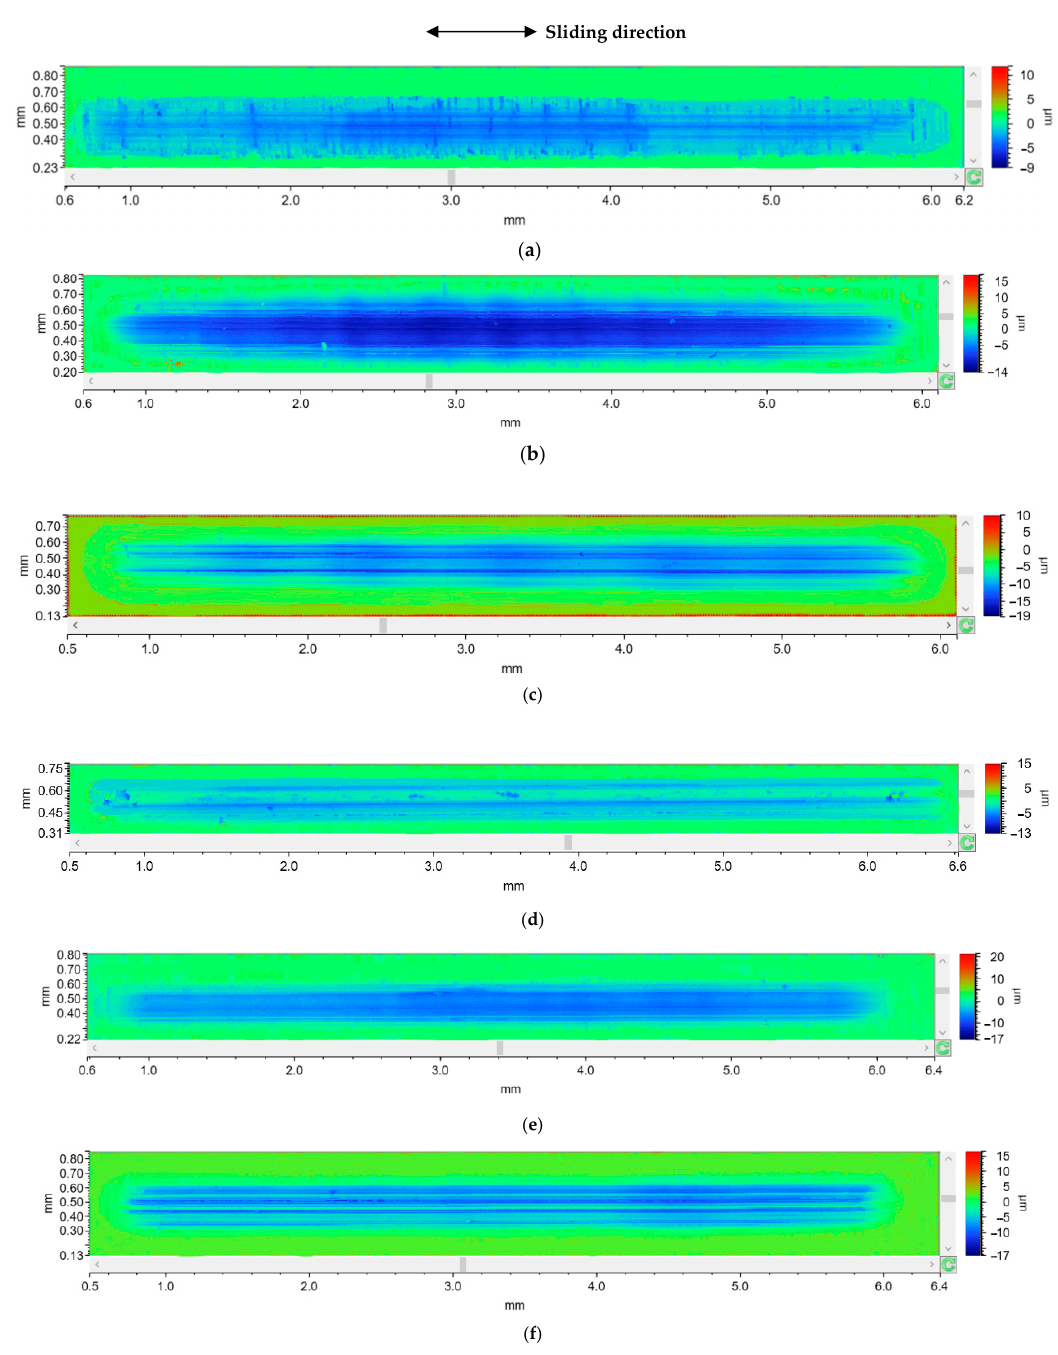
Figure 9. 3D morphology after friction at different temperatures. ( a ) The hardened layer after laser hardening at a scanning speed of 700 mm/min, at 20 °C and sliding speed 500 mm/min. ( b ) The hardened layer after laser hardening at a scanning speed of 700 mm/min, at 110 °C and sliding speed 500 mm/min. ( c ) The hardened layer after laser hardening at a scanning speed of 700 mm/min, at 200 °C and sliding speed 500 mm/min. ( d ) The hardened layer after laser hardening at a scanning speed of 800 mm/min, at 20 °C and sliding speed 500 mm/min. ( e ) The hardened layer after laser hardening at a scanning speed of 800 mm/min, at 110 °C and sliding speed 500 mm/min. ( f ) The hardened layer after laser hardening at a scanning speed of 800 mm/min, at 200 °C and sliding speed 500 mm/min.